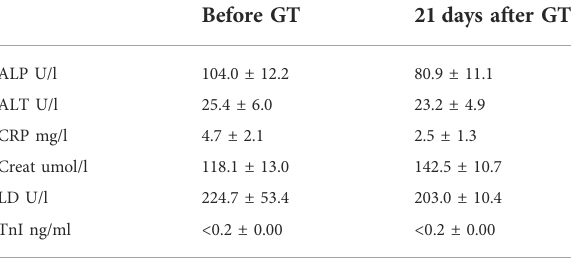
TABLE 1 AdVEGF-D Δ N Δ C gene transfer did not cause signi fi cant changes in blood parameters. Table shows mean values and standard deviations before the gene transfer and 21 days after the gene